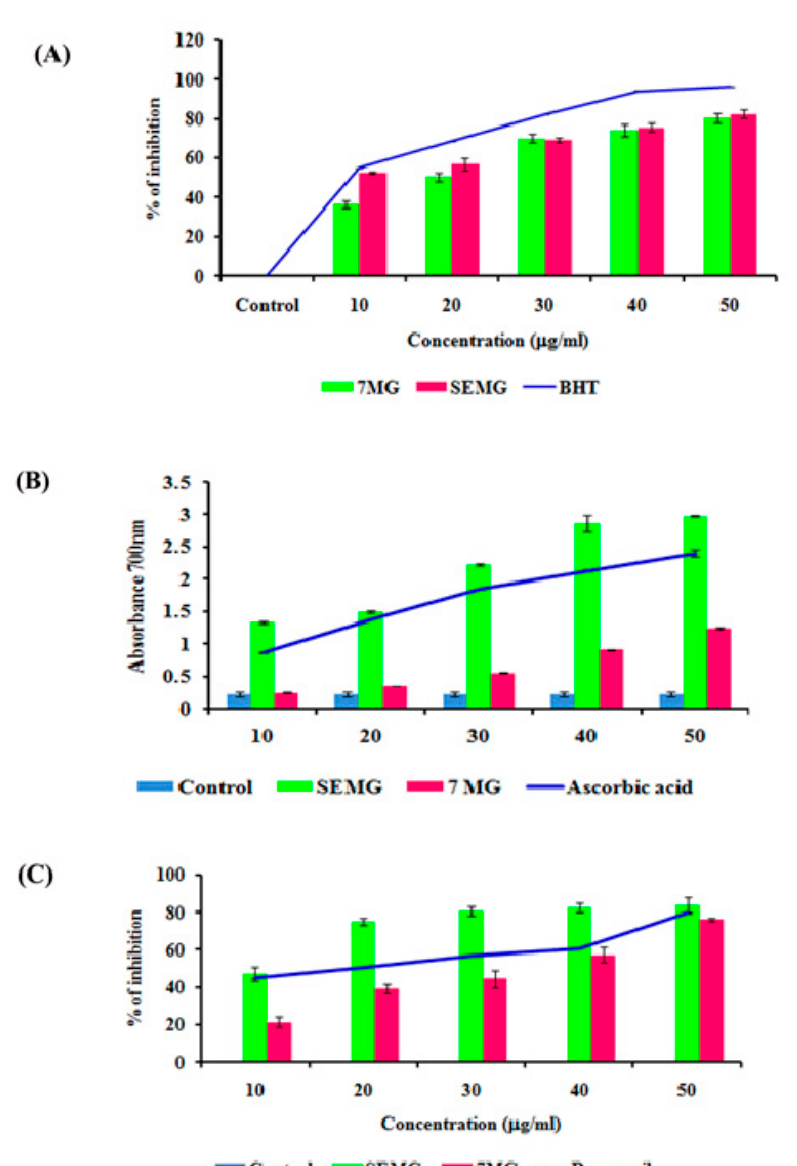
Figure 3. ( A ) Free radical scavenging activity of SEMG compared to standard Butylated hydroxytoluene, ( B ) Reducing power of SEMG in comparison with positive control ascorbic acid, ( C ) Acetylcholinesterase inhibitory activity of SEMG compared to standard drug donepezil. Results are expressed as Mean ± SD of triplicate assays.